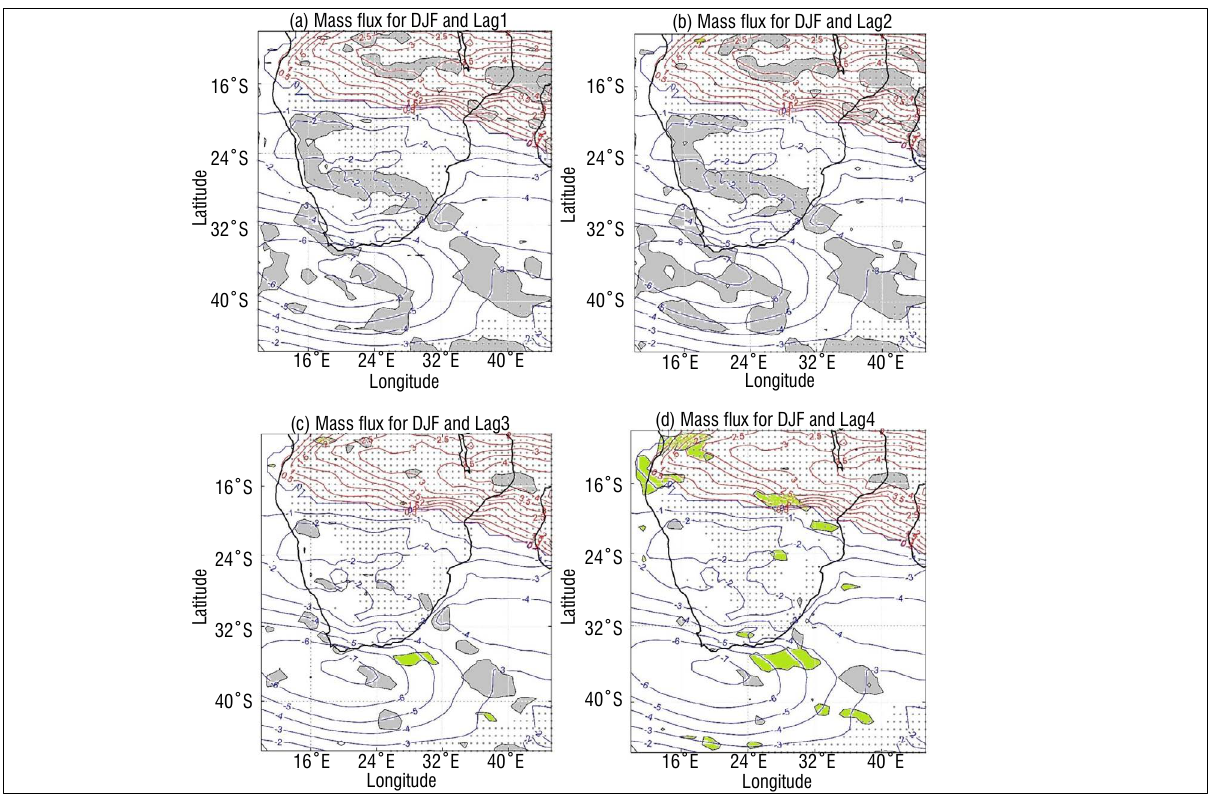
) in December–February (DJF); units are kg/m 2 s. Negative (positive) values of the mass flux are represented Figure 3: Seasonal mean of (a–d) the mass flux (m ϕ by the blue (red) contours. The contours are plotted in 10 3 kg/m 2 s intervals. Correlation coefficients for the Hadley cell and total cloud cover relation in DJF for (a) Lag 1, (b) Lag 2, (c) Lag 3 and (d) Lag 4. Grey shading denotes correlation coefficients greater than 0.3 and green shading indicates correlation coefficients less than -0.3. Regions of upward vertical velocity ( ω ) in Pa/s are represented by grey dots. Where there are no grey dots, there is downward motion (i.e. ω > 0).